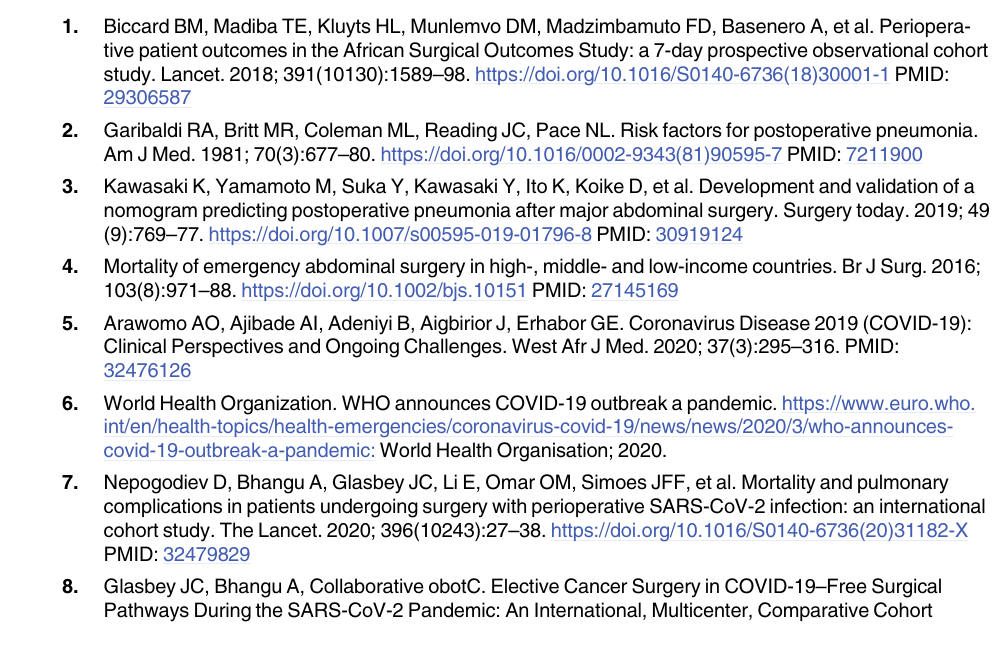
S1 Fig. PRISMA flow